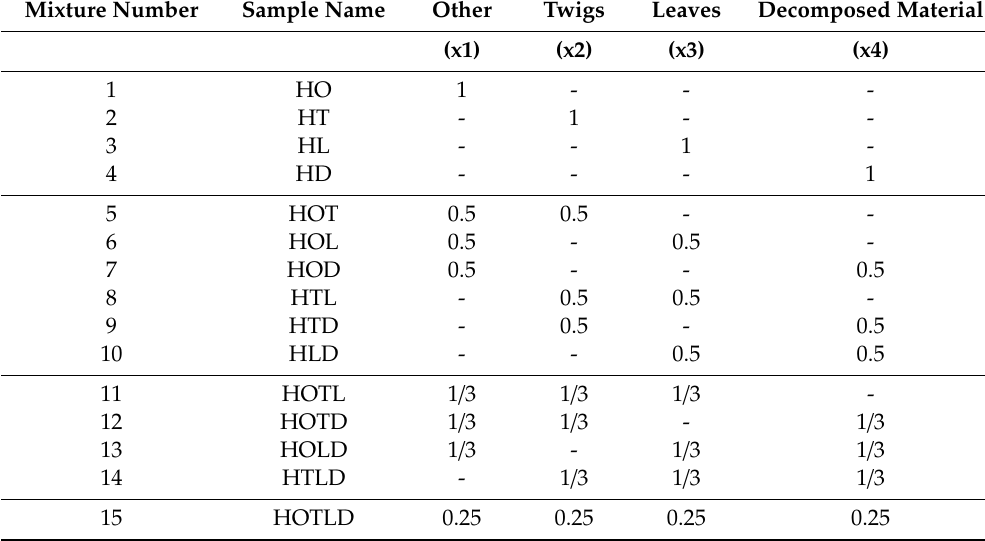
Table 1. Key to flammability combinations for litter from Halls Creek (H): other (O), twigs (T), leaves (L), decomposed material (D). The values represent the proportion of each litter component within a